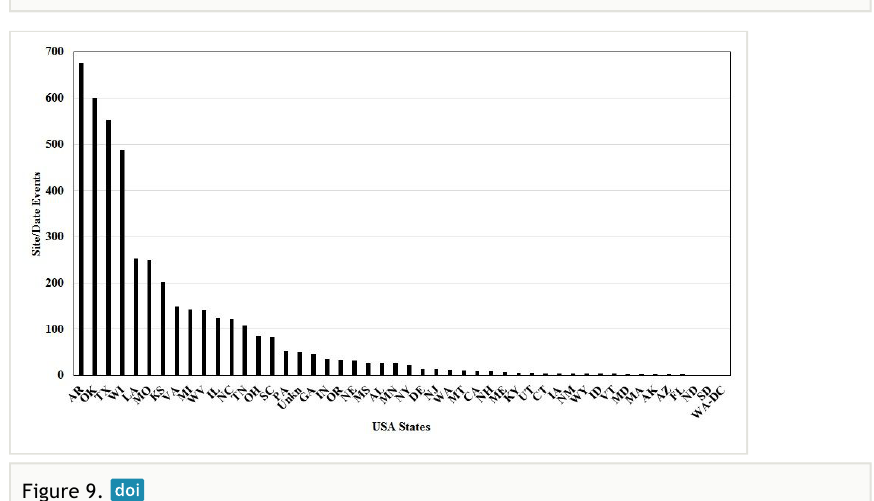
Figure 9. Number of site/date events for Plecoptera specimens from 48 United States and Washington